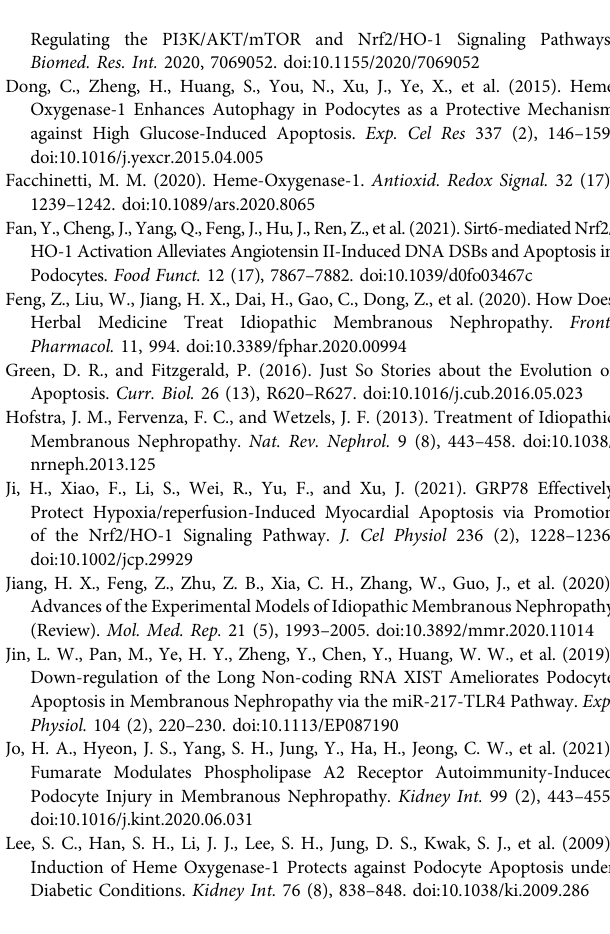
Supplementary Figure 1 | Chemical pro fi les of SQ. UV chromatogram of SQ at 205 nm (A) and 284 nm (B) was presented. 11 peaks were identi fi ed as follows: (1) caylcosin-7-O- β -D-glucopyranoside, (2) ononin, (3) 6aR, 11aR-3-hydroxy-9,10- dimethoxypterocarpan-3-O- β -D-